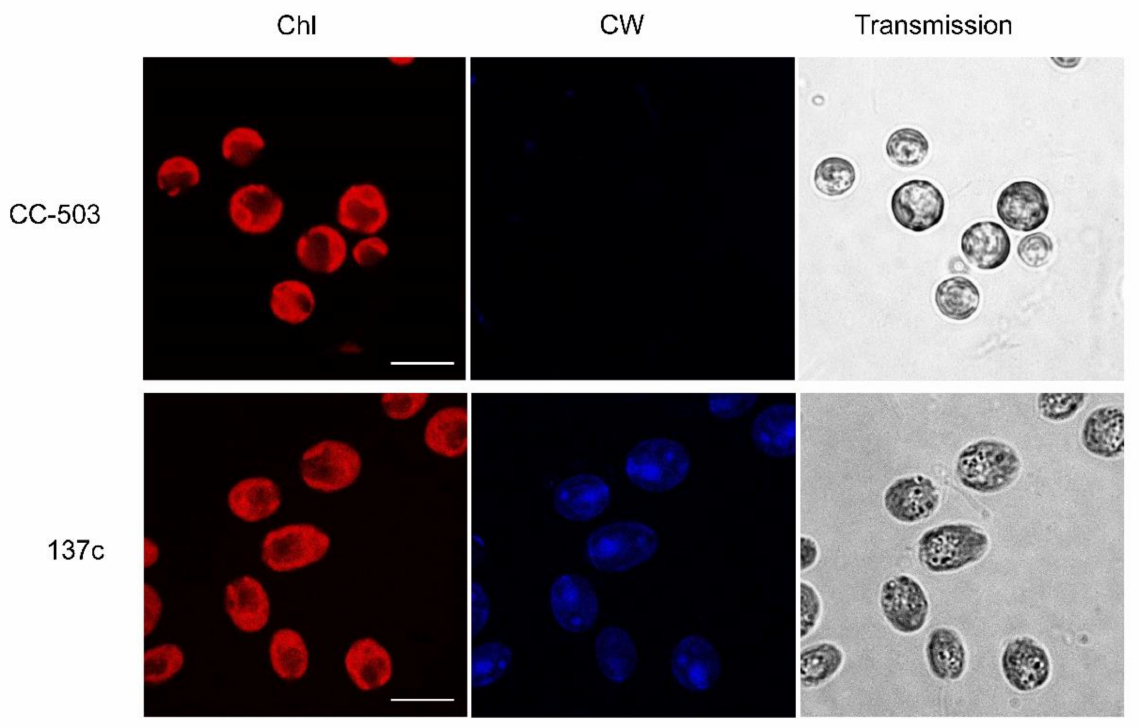
Figure 1. Transmitted images of algal cells obtained with confocal microscopy for determination of Chl autofluorescence (Chl) and fluorescence of Calcofluor white (CW). CC-503 and 137c are strains of C. reinhardtii without and with a well-formed cell wall, respectively. The scale bar is 10 µ